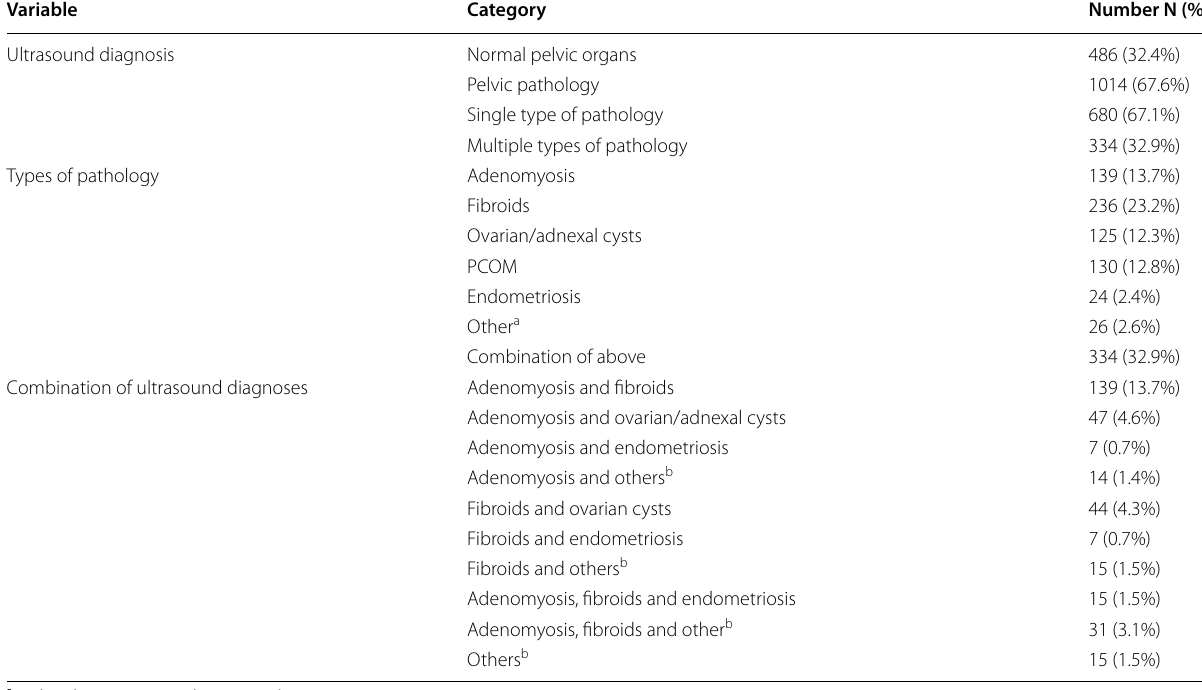
Table 3 Ultrasound diagnoses for women presenting to the gynaecology clinic ( N